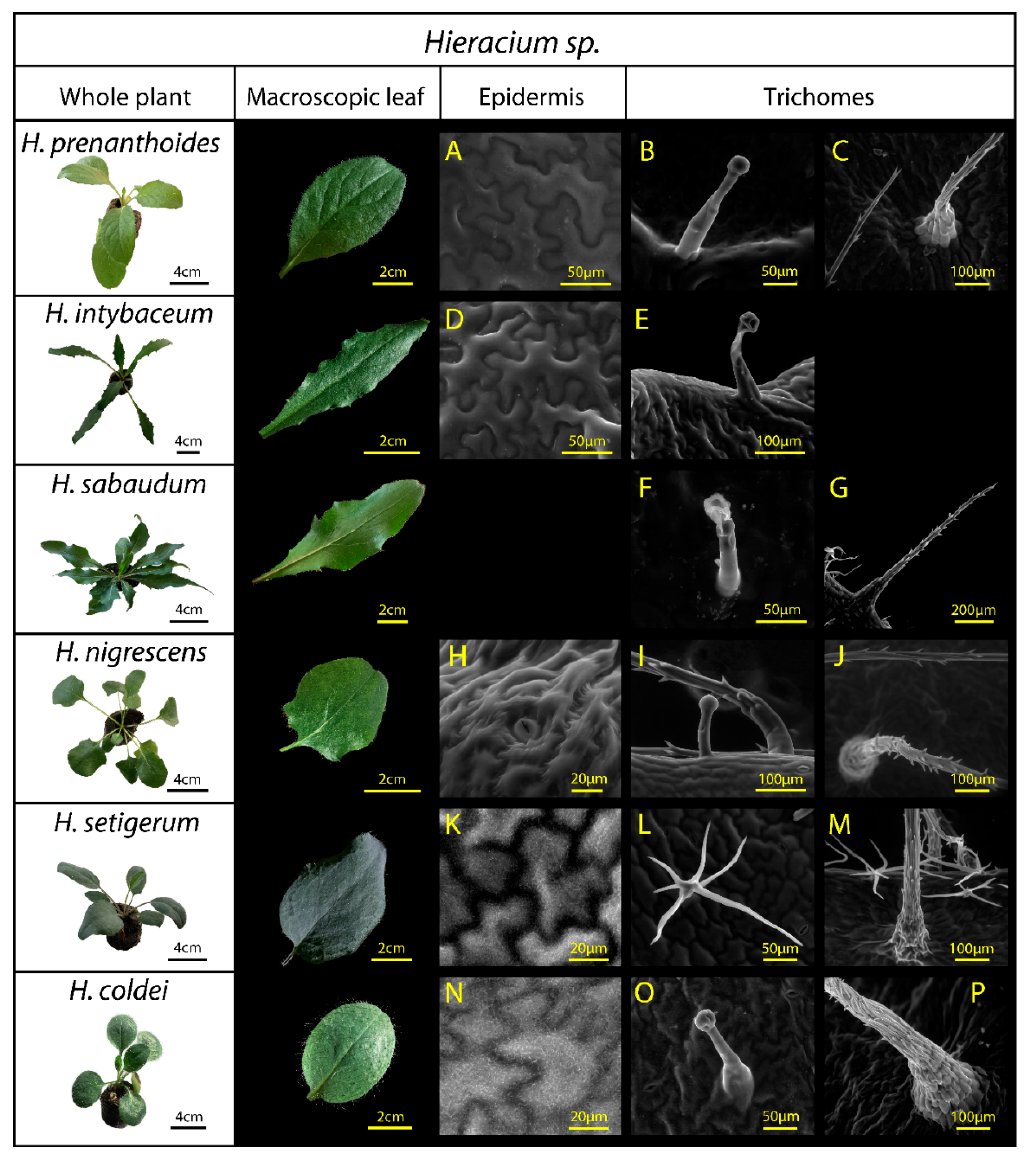
Figure 2. Hieracium species used in the study: H. prenanthoides , H. intybaceum , H. sabaudum , H. nigrescens , H. setigerum , and H. coldei . The three columns on the right ( A – P ) present epidermal surface observations by environmental scanning electron microscopy. Third column: leaf epidermal pavement cells without waxes ( A , D , H ), and with a wax layer on the epidermal pavement cells ( K , N ). Fourth column: glandular trichomes ( B , E , F , I (a smaller one), O ) and branched (stellate) trichome in H. setigerum ( L ). Fifth column: multicellular stiff trichomes ( C , G , I (base of the trichome at right)) J , M (base of the trichome in front), P (base of the trichome). For expanded description of surface structures, see Table 2. Due to the epidermal cell collapsing during ESEM acquisition, we did not include H. sabaudum epidermal cells in the figure; however, we did not observe there any surface waxes, or roughness on the surface, which could influence leaf reflectance.